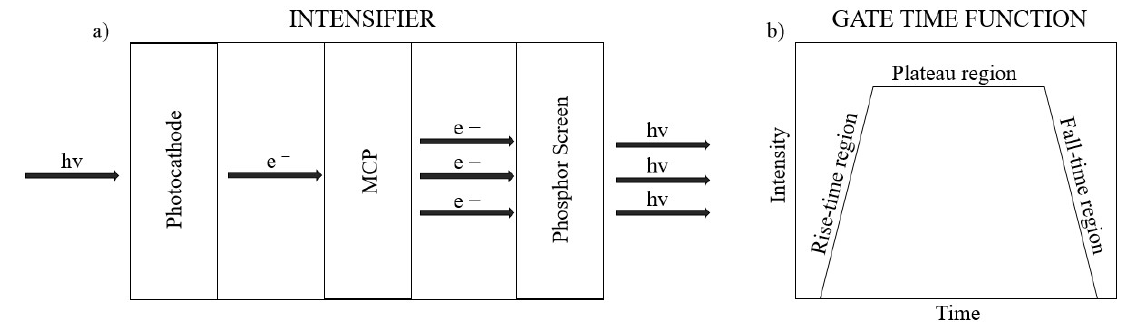
Figure 1. Sketch of an ICCD intensifier ( a ) and of an ICCD gate on mode function showing how voltage (directly proportional to intensity) changes with time ( b